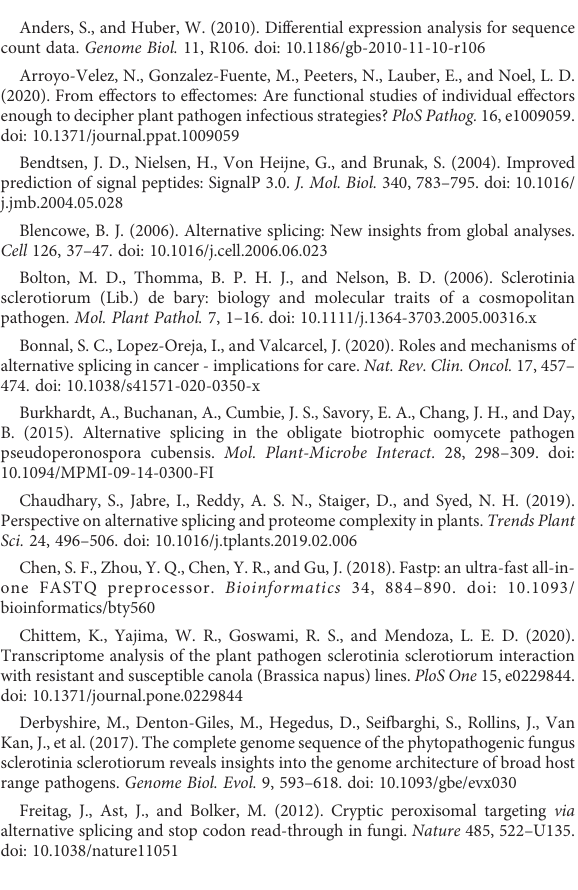
SUPPLEMENTARY FIGURE 1 Correlation between the RNA-seq data. (A) Hierarchical clustering analysis of the gene expression levels in S. sclerotiorum at 0, 2, 6, 12, 24, and 36 hpi. The color bar represents the distance between samples, with red signifying a short distance and blue signifying a long distance between samples. The color bar (from blue to red) refers to the distance SUPPLEMENTARY FIGURE 2 Venn diagram of differential alternative splicing genes (DASGs). (A) Venn diagramofDASGsatdifferentinfectionstages. (B) VenndiagramofDASGs